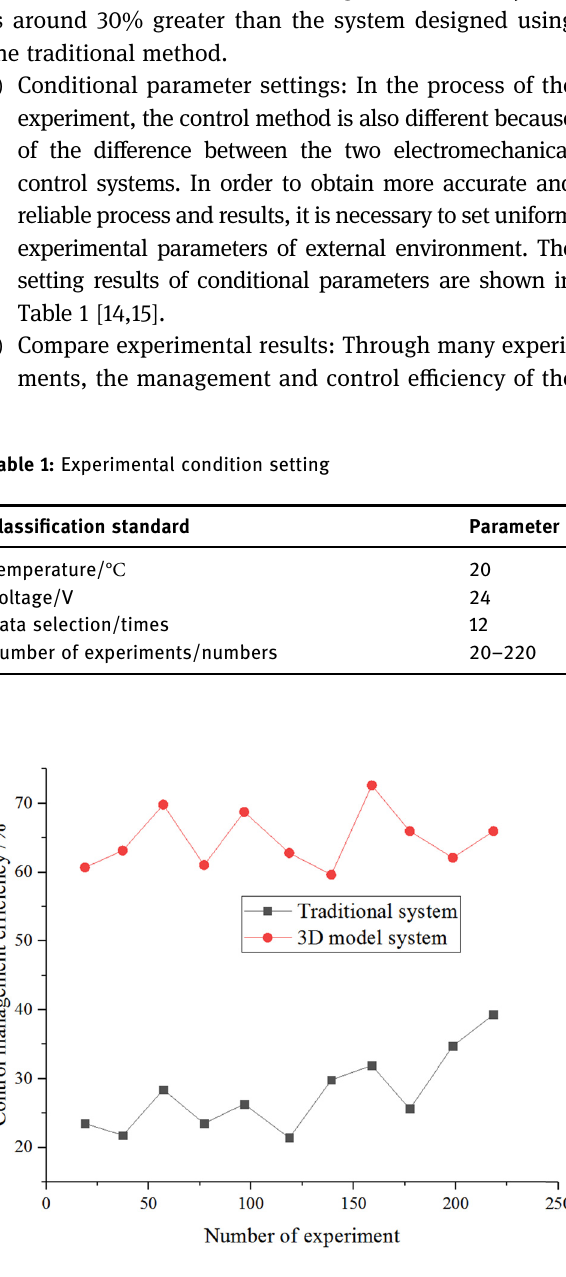
Figure 3: Experimental comparison results.